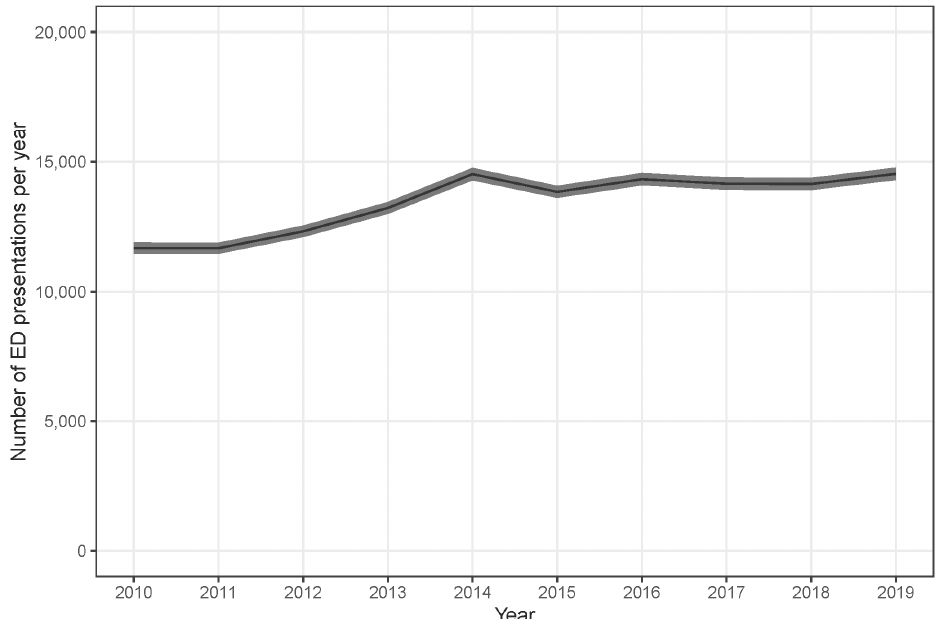
Figure 2. Annual incidence of paediatric injury-related ED presentations, 1 January 2010 to 31 December 2019 ( N = 134,484).